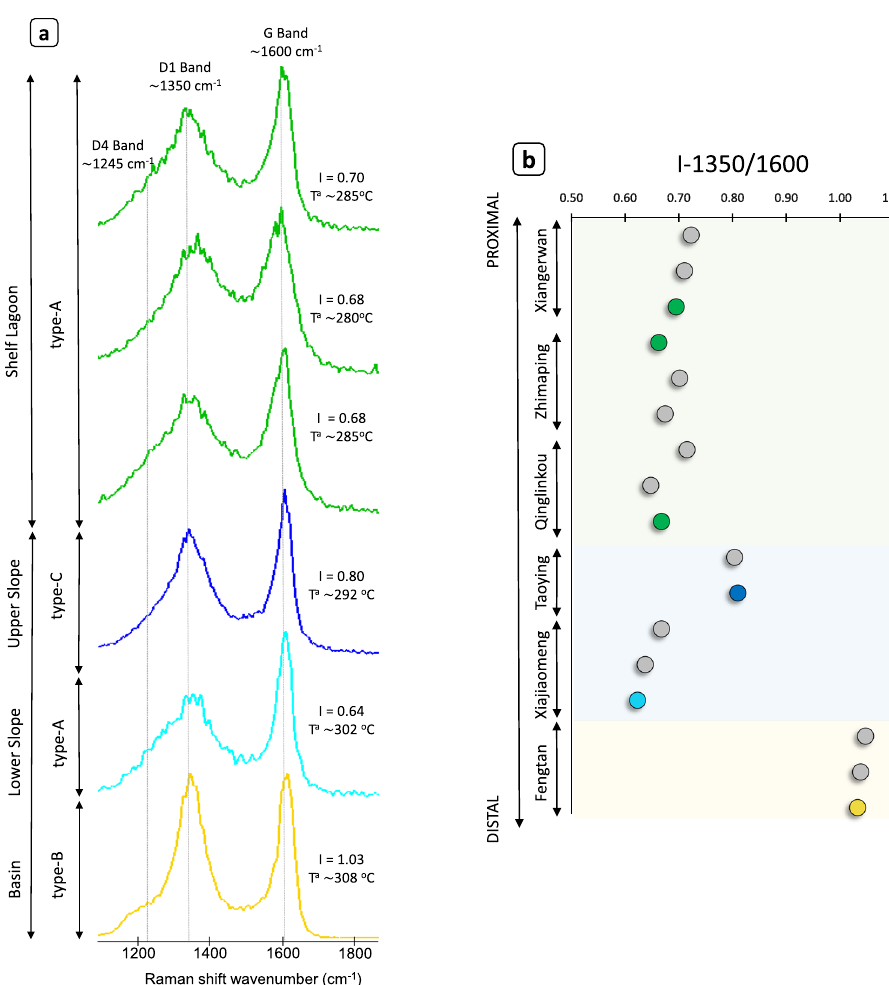
Fig. 3 Raman spectra of organic matter in Doushantuo Member IV. a Raman spectra are organized by depositional environments and show the disordered but variable structure of the different kerogen types proposed (A, B and C). The two broad bands at ∼ 1350 cm − 1 and ∼ 1600 cm − 1 are used to calculate peak metamorphic temperatures and yield an intensity ratio de fi ned as I-1350/1600 (I in this fi gure). D4 band is a secondary band that shows a well-developed shoulder in the basin sample. b Compilation of I-1350/1600 results from seventeen samples of the studied sections showing the distribution of the calculated intensity ratio along the basin. The colored circles represent samples shown in a